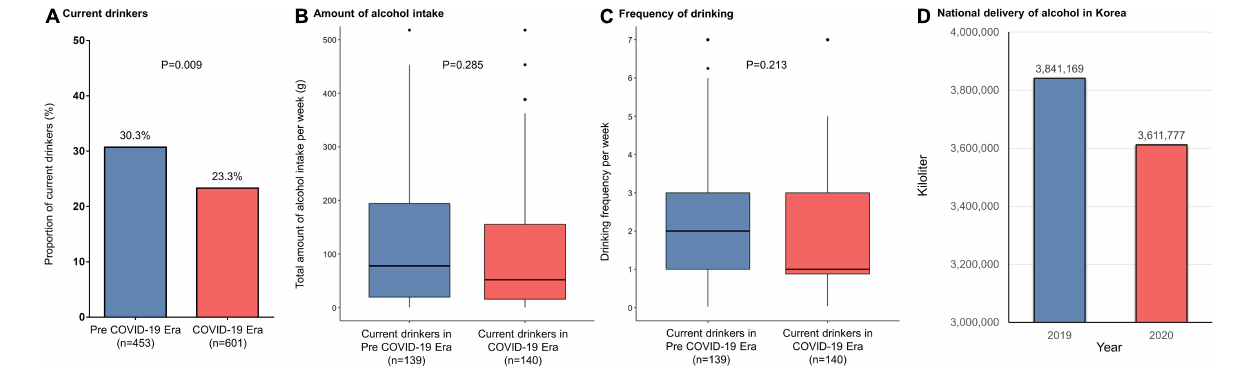
Frontiers in Cardiovascular Medicine |